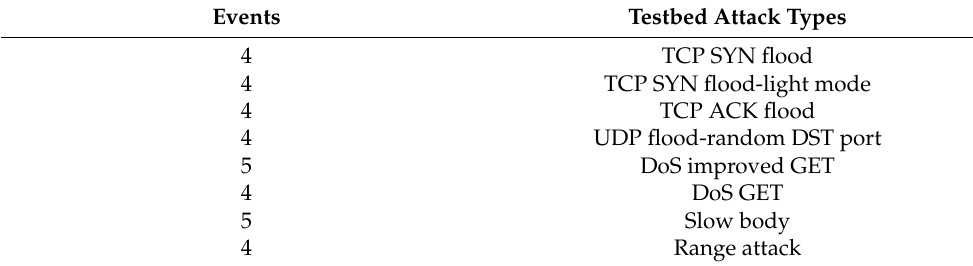
Figure 4. Local testbed design. Table 4. CIC-DoS 2017 dataset.